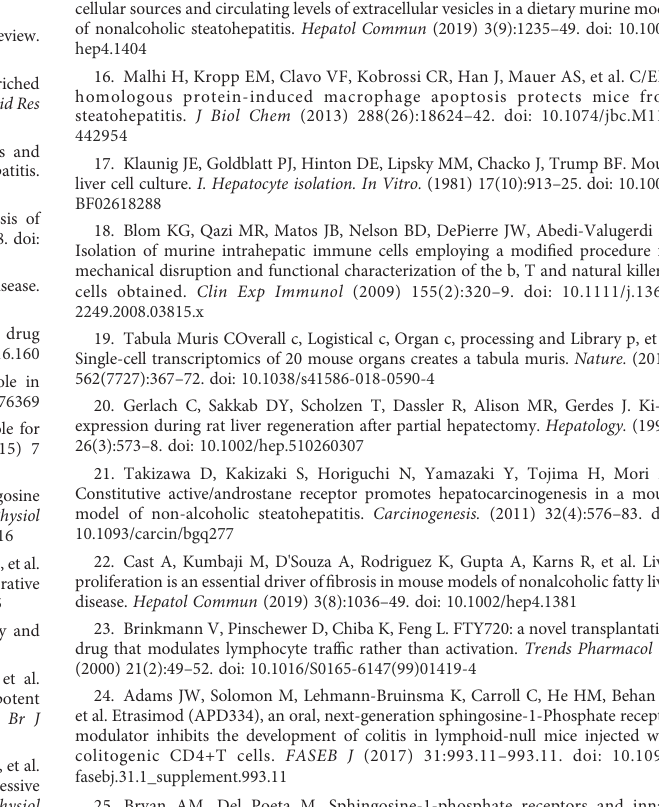
SUPPLEMENTARY FIGURE 3 Viability plot for fl ow cytometry. (A) Representative image shows viability of samples using live/dead cells counts by employing Zombie Aqua dye. SUPPLEMENTARY FIGURE 4 Amiselimod treatment alters some intrahepatic leukocyte populations. (A) Number of CD45 + cells per gram acquired for FACS analysis in CD and FFC cohorts. (B) SubsetsofCD45 + cellsand (C) immunecellsexpressed in%CD45 that are T cells, B cells and NKT cells by FACS analysis in livers from CD and FFC cohorts that received vehicle or Amiselimod treatment. Quanti fi cations are expressed as %CD45 cells or total number. (D) T-cell subtypes expressed in %CD45 cells that are CD4 positive, CD8 positive or double negative in CD and FFC cohorts. (E) Subsets of CD45 + cells including NK cells, CD11b + myeloid cells, PMNs and DCs and (F) immune cells expressed in %CD45 that are NK cells, CD11b + , PMNs and DCs. CD (vehicle n=4, Amiselimod n=5) and FFC (vehicle n=5, Amiselimod n=6). *p<0.05, **p<0.01, ***p<0.001. SUPPLEMENTARY FIGURE 5 Macrophage accumulation and in fl ammatory markers are reduced in Amiselimod treated mice. (A) Representative images showing immunohistochemistry for Mac-2 in liver tissue sections for vehicle and Amiselimod treated mice in both CD and FFC cohorts. Scale bar equals 50 m m. (B) Mac-2 staining was quanti fi ed as percentage of positive immunoreactive area in CD and FFC-fed mice treated with vehicle or Amiselimod. (C-E) Relative mRNA expression of Cd68, Lgals3, Ly6c in CD and FFC cohorts treated with vehicle or Amiselimod. (F-H) Relative mRNA expression of monocyte chemoattractant protein-1 (Mcp1) , Tumor necrosis